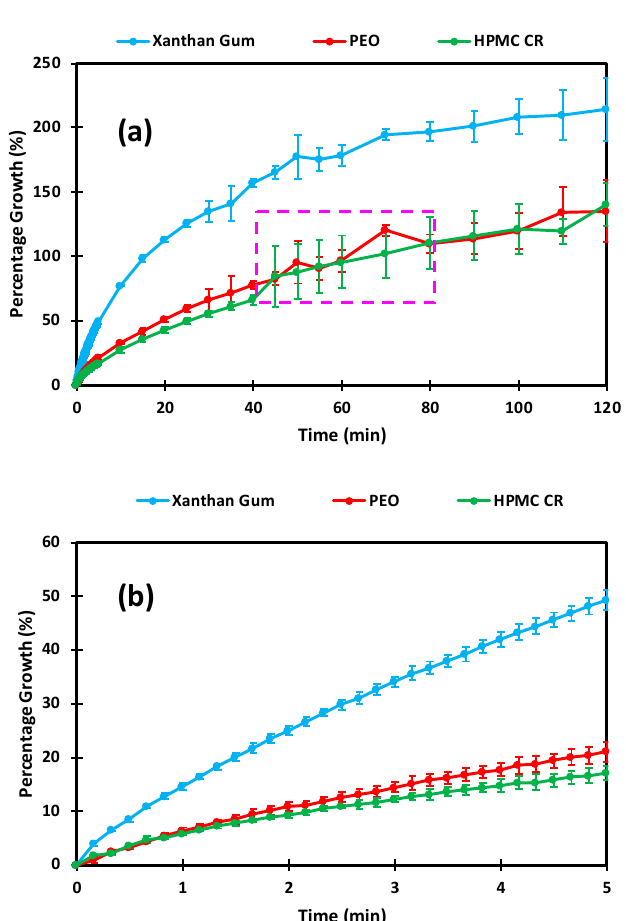
Figure 6. Optical images obtained from the dissolution imaging system at the 520 nm wavelength: ( a ) XG, ( b ) PEO, and ( c ) HPMC CR. Note: Images are taken from the 2 h experiment at time intervals of 1, 2, 5, 20, 30, 60, 90 and 120 min. XG is xanthan gum, PEO is polyethylene oxide, and HPMC CR is hypromellose K100M CR grade.